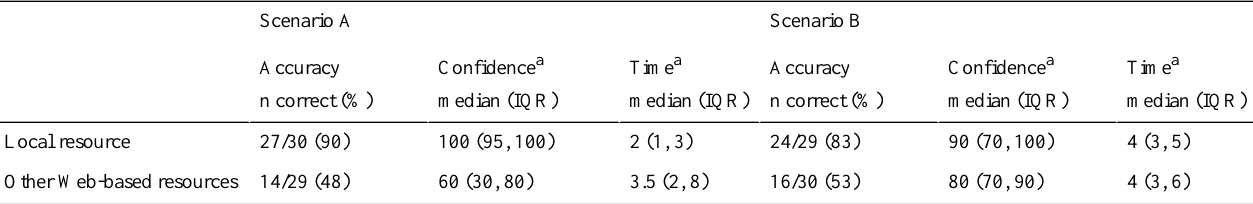
Table 2. Accuracy, confidence, and time to answer question.